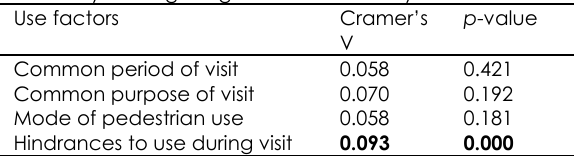
Figure 6. Influence of hindrances to use on the perception of quality of Zoological gardens in Federal Universities in the South-west Nigeria. Table 6. Use factors influencing satisfaction of users with the university. Zoological gardens in the study